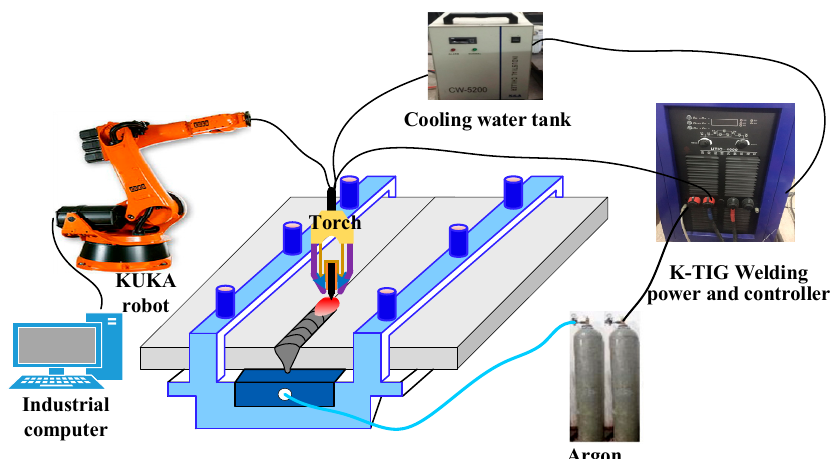
Figure 1. Schematic diagram of keyhole tungsten inert gas (K-TIG) welding.